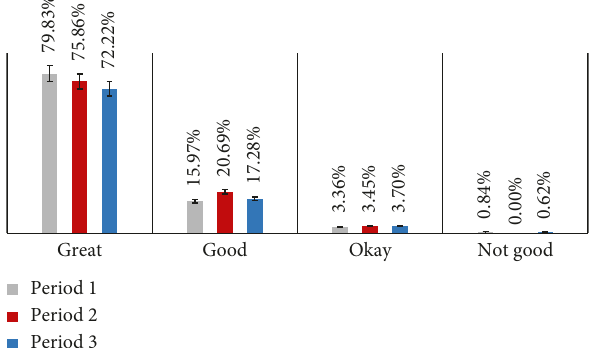
Figure 2: Overall satisfaction with physician by period. Error bars represent standard error of those answering